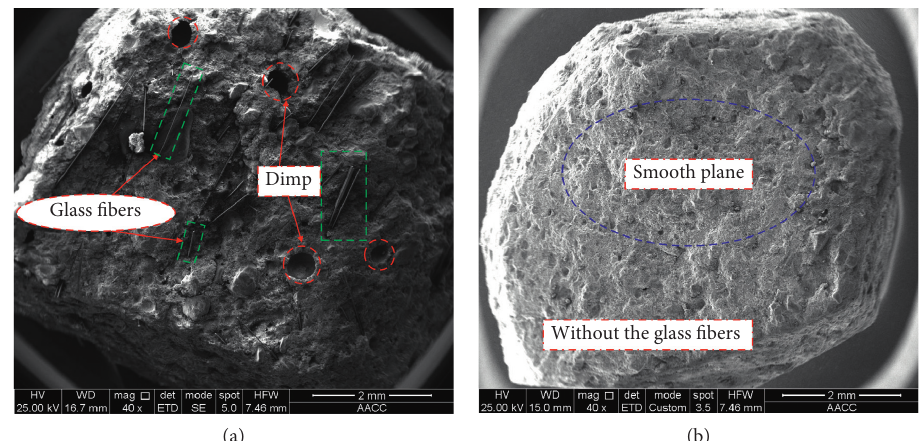
Figure 12: The microstructure of SCPB specimens with and without doped glass fibers at a 1d curing age. (a) With glass fibers. (b) Without glass